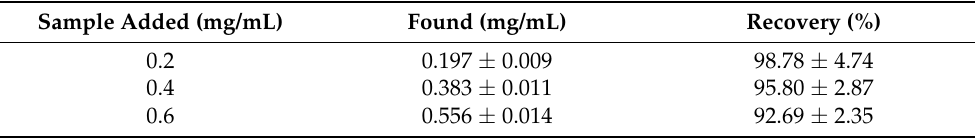
Figure 7. ( a ) Cyclic voltammograms of different concentrations of ascorbic acid (0.1–1.0 mg/mL). ( b ) The calibration curve between current (µA) and concentration of ascorbic acid (mg/mL). The current observed at 550 mV was used to plot the calibration curve to determine the ascorbic acid concentration. Table 3. Analyses of ascorbic acid in spiked commercial drinking water measured by cyclic volt- ammetry ( n = 3).